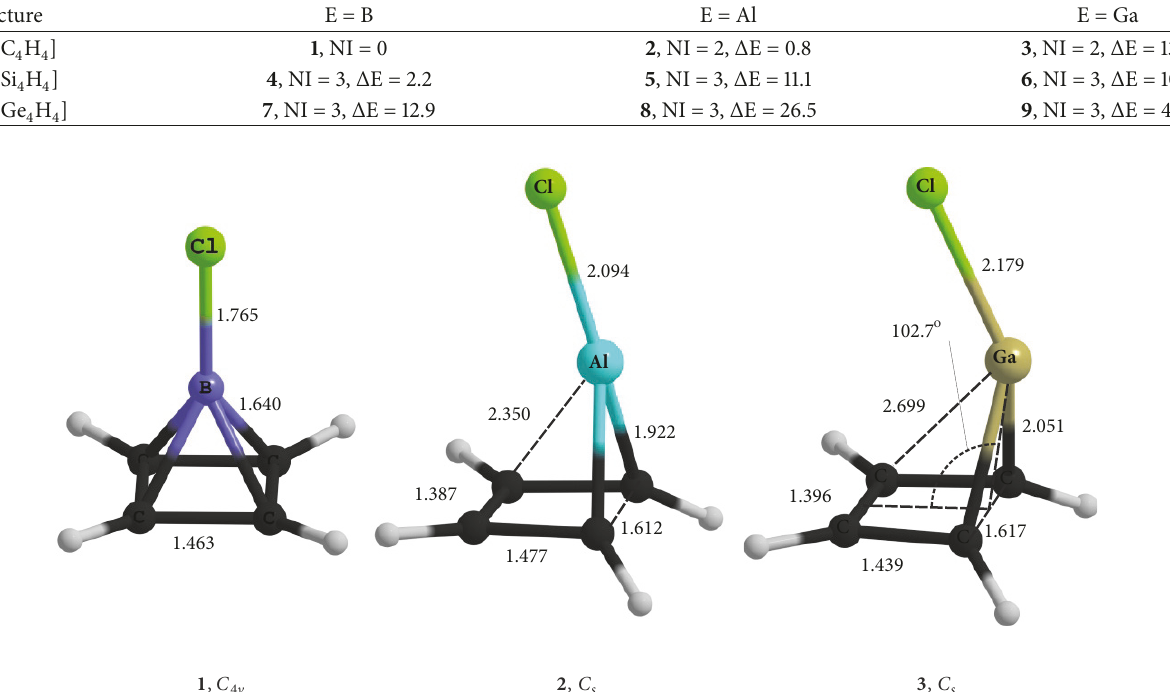
Figure 1: Optimized geometries (bond lengths are in ˚A) of minima structures 1–3